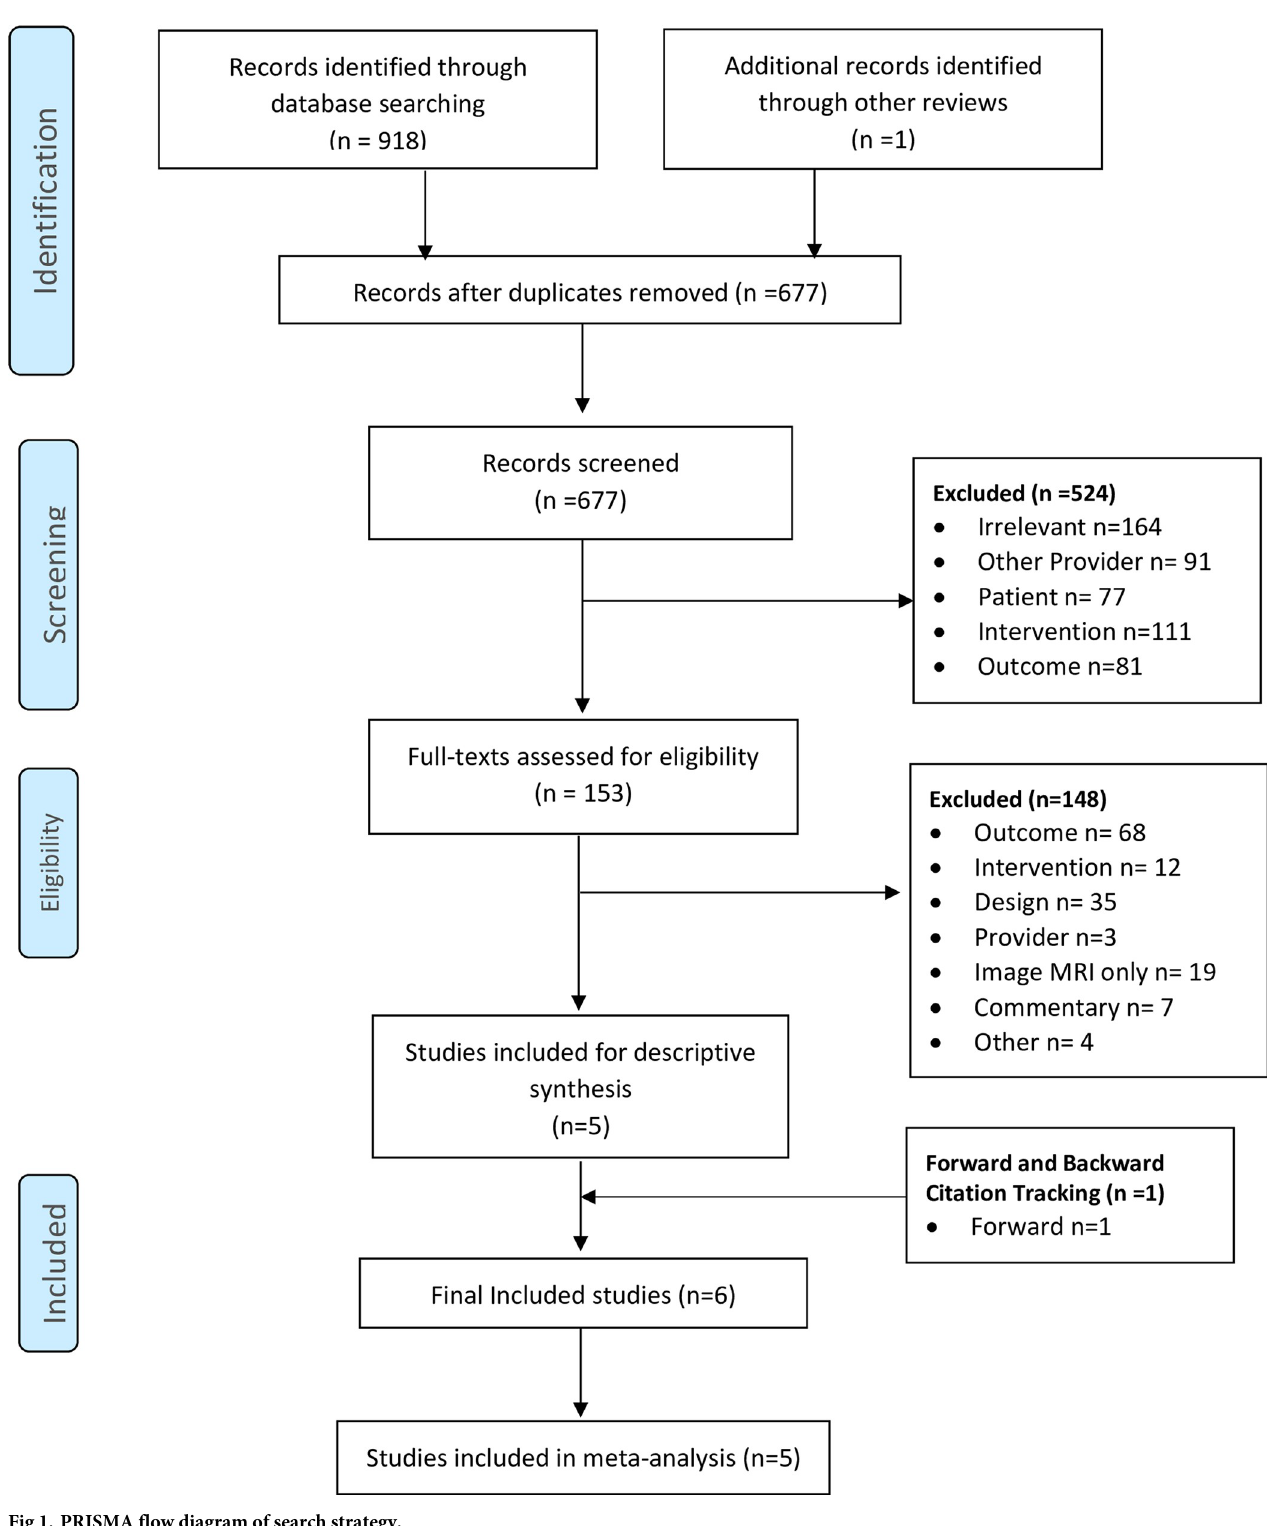
Fig 1. PRISMA flow diagram of search strategy.